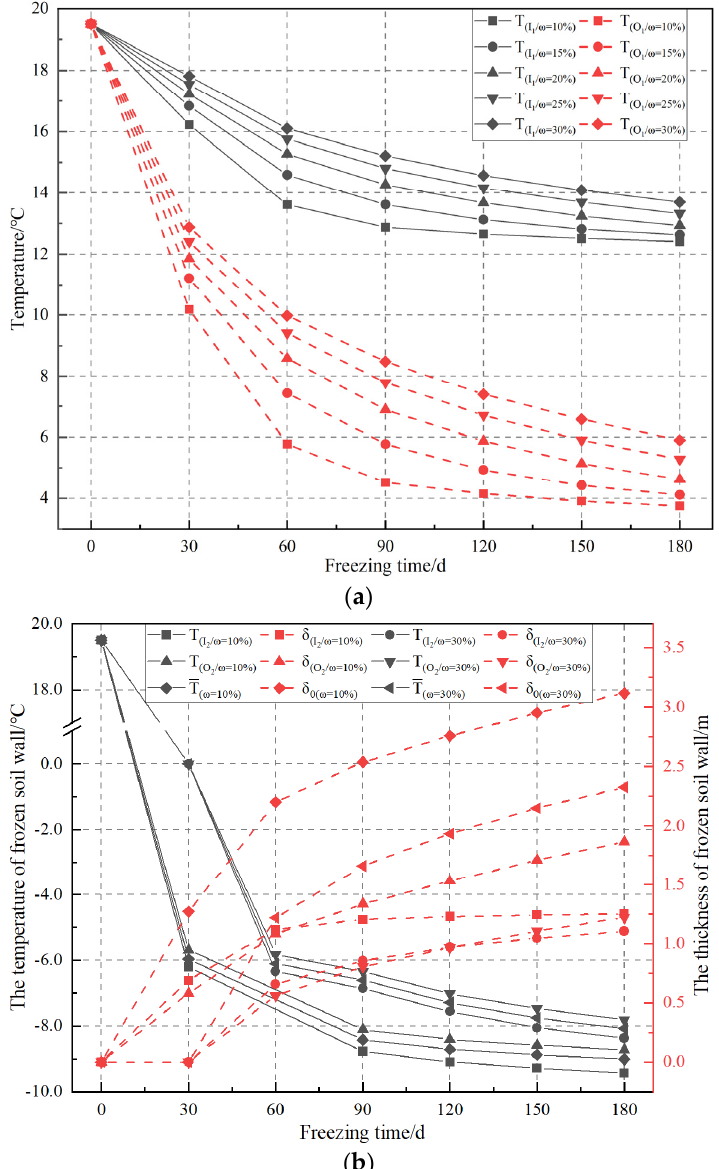
Figure 18. Variance in temperature and thickness under different soil moisture contents and freezing time: ( a ) temperature in interlayer and outside wall of shaft, ( b ) temperature and thickness in the inside and outside of frozen soil wall and its average or sum value with soil moisture content of 10% and 30%.